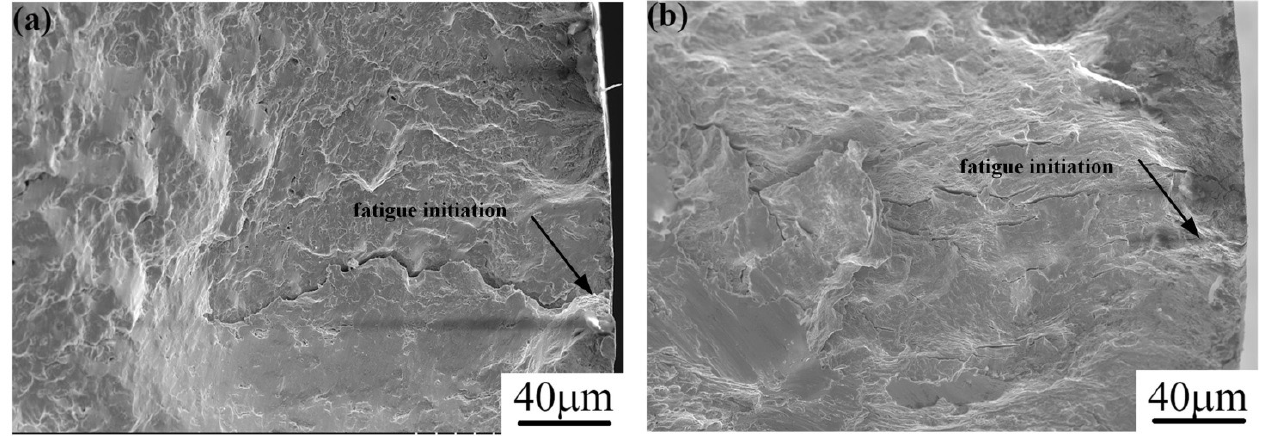
Figure 10. Micro-morphologies of crack initiation zone at 0.52% total strain amplitude ( a ) 22MnSi2CrMoNi steel and ( b ) 00Ni18Co9Mo4Ti steel.